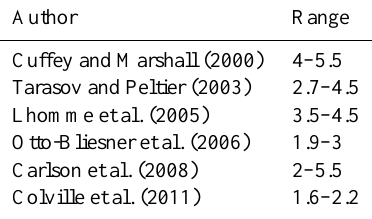
Table 1. Overview of estimated GIS contribution (m) to LIG sea- level high stand. Both data and combined model–data studies are